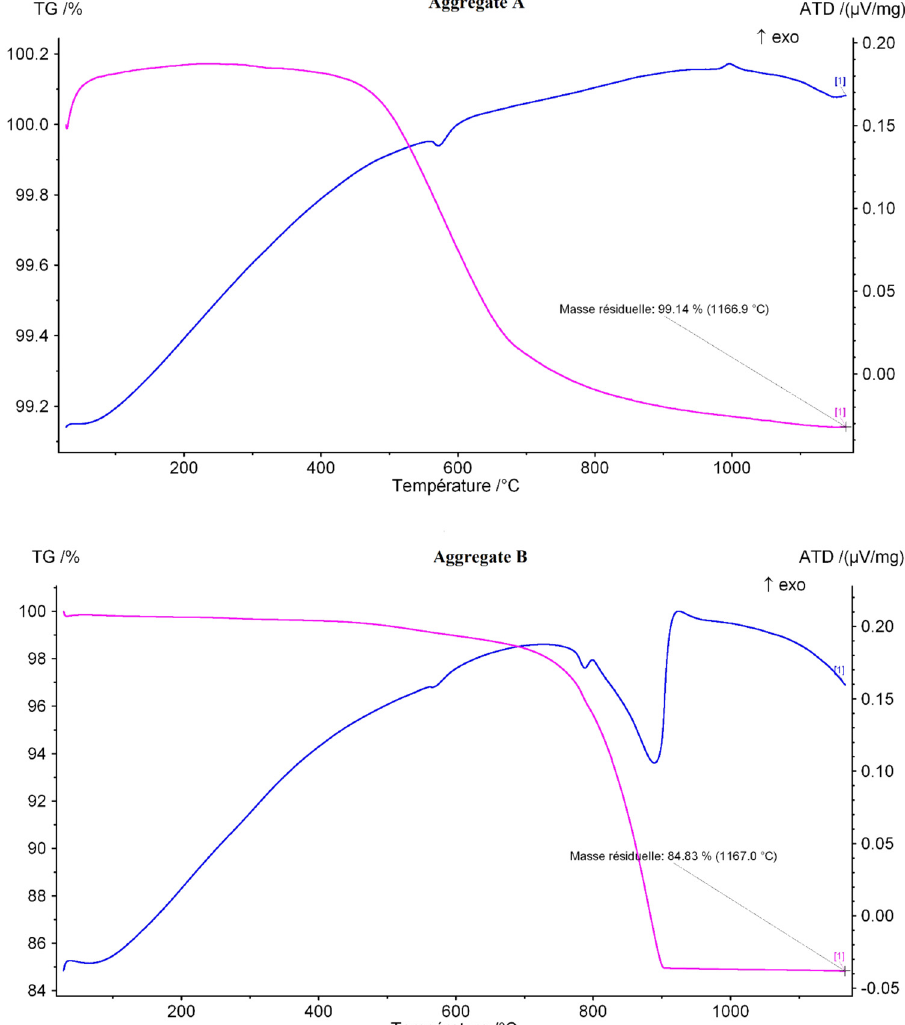
Figure 6: TGA/DTA of the aggregates A and